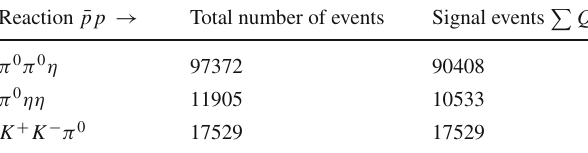
Table 1 Number of selected events for all three